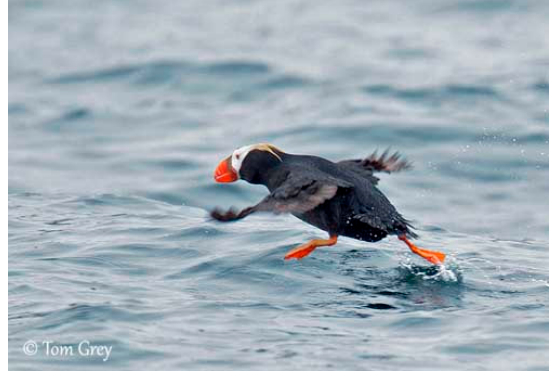
Figure 3. The puffin during stage I of the take-off run, where thrust T has a dominant role over lift L [7].